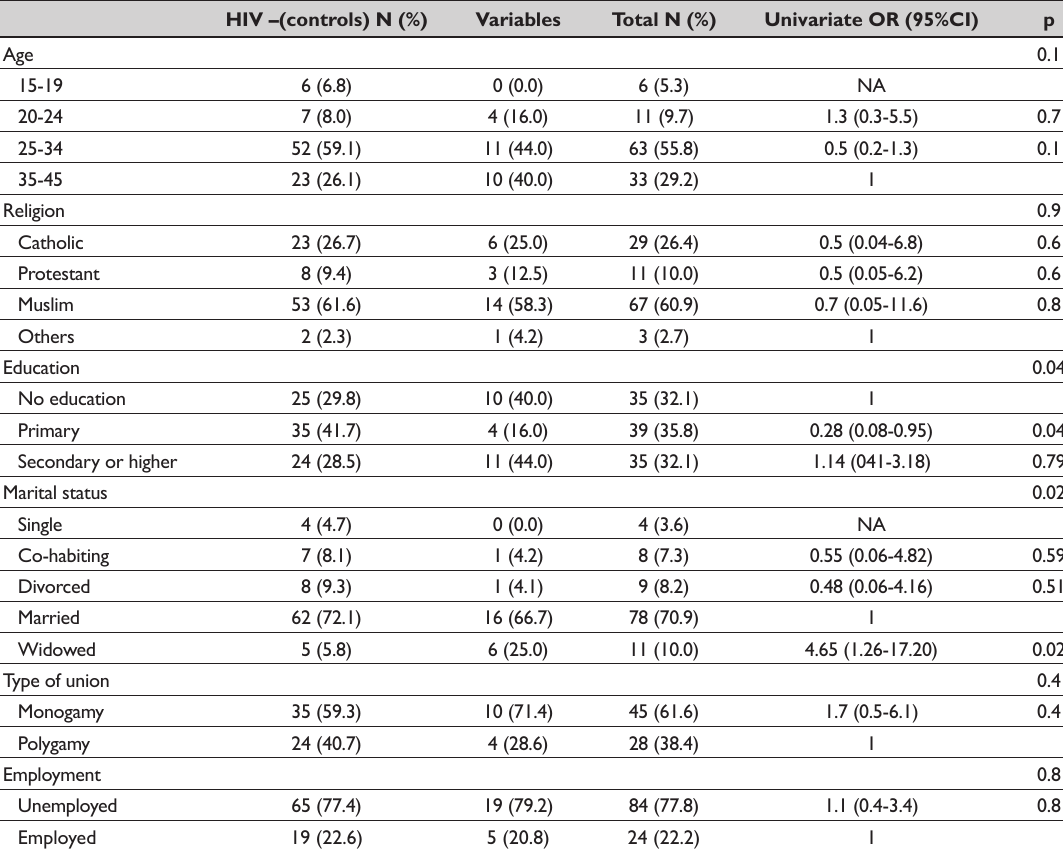
Table 2: Univariate associations between maternal socio-demographic factors and children’s HIV status HIV –(controls) N (%)